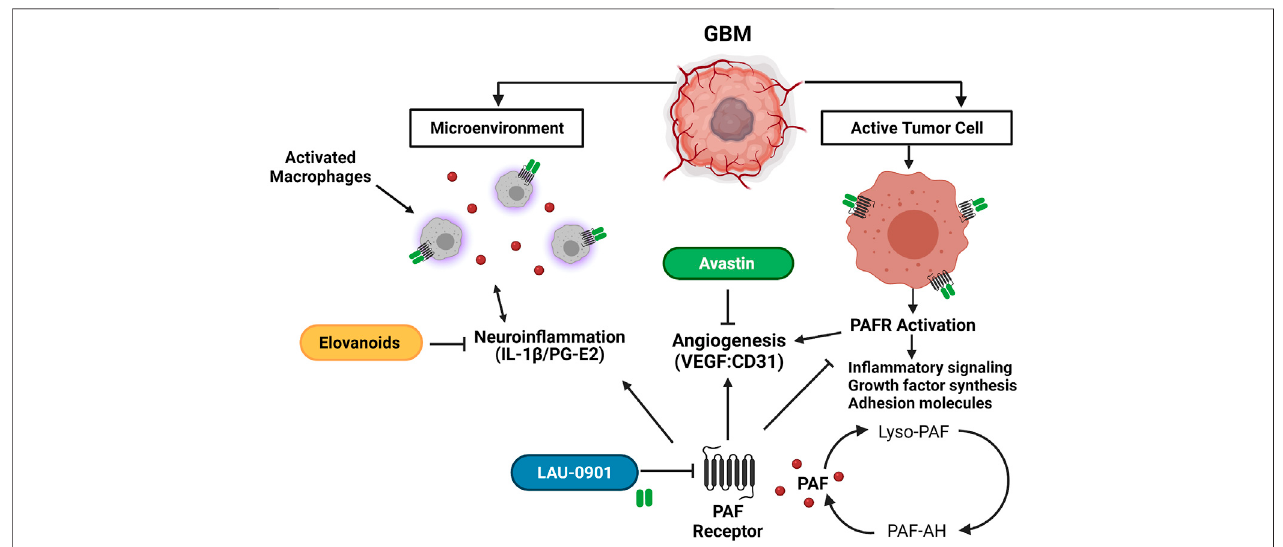
FIGURE 1 | Schematic representation of the potential targets of LAU-0901, Elovanoids, and Avastin in the GBM tumor microenvironment. LAU-0901 a selective PAFRantagonistpreventsover-activationofPAFR.ExcessiveproductionofPAFandoveractivationofPAFRincreasessynthesisofgrowthfactors,adhesionmolecules, in fl ammatory signalin and promotes angiogenesis. ELVs target pro-in fl ammatory signaling pathways which plays a role in the tumor microenvironment inhibiting proliferation and migration of cancer cells. Avastin is a monoclonal antibody, which prevents VEGF binding, thus inhibiting angiogenesis.